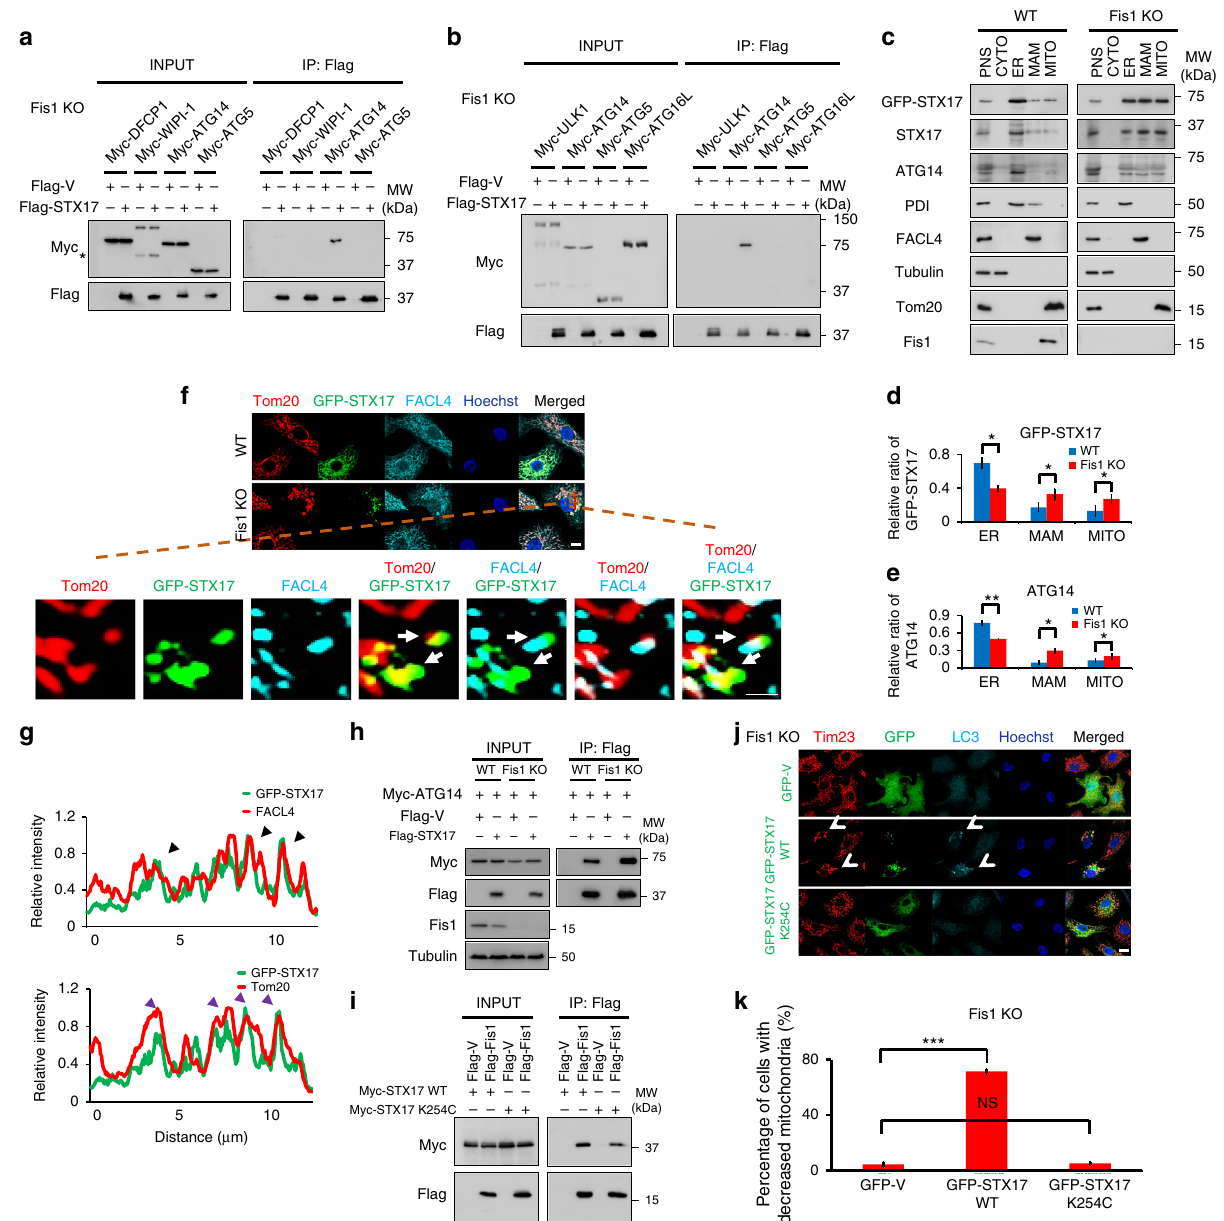
Fig. 5 Mitochondrial fi ssion 1 protein (Fis1) regulates the translocation of syntaxin 17 (STX17) onto MAM/mitochondria. a , b Fis1 knockout ( KO ) HeLa cells were transfected with the indicated plasmids. After 24 h, cells were lysed and immunoprecipitated with anti-Flag beads followed by immunoblotting. Asterisk indicates a non-speci fi c band. c Immunoblotting of subcellular fractions from wild-type ( WT ) or Fis1 KO HeLa cells expressing green fl uorescent protein (GFP)-tagged STX17 for 24 h is shown. PNS, post-nuclear supernatant; CYTO, cytosol; ER, endoplasmic reticulum; MAM, mitochondria-associated membranes; MITO, mitochondria. d , e Quanti fi cation of relative ratio of GFP-tagged STX17 ( d ) or endogenous ATG14 ( e ) in the respective subcellular fractions. * P < 0.05, ** P < 0.01 (two-tailed unpaired Student ’ s t test from three independent experiments). f WT or Fis1 KO HeLa cells were transfected with GFP-tagged STX17 (green). Cells were imaged following immunostaining for Tom20 (red) and FACL4 (fatty acid-CoA ligase 4) (cyan). Images at single focal plane were acquired. Hoechst, blue. Scale bar, 10 µ m. Cropped image was enlarged and shown as a two-dimensional deconvoluted example. White arrows indicate the colocalization of STX17 with Tom20 (mitochondria) and FACL4 (MAM). g Line scans corresponding to f . The colocalization between GFP-STX17 with FACL4 (MAM) or Tom20 (mitochondria) of Fis1 KO cells is indicated by black triangles or purple triangles, respectively. h Plasmids encoding respective proteins were transfected into WT or Fis1 KO HeLa cells for 24 h. Cells were extracted and immunoprecipitated with anti-Flag beads, followed by immunoblotting. i Plasmids as indicated were transfected into HeLa cells. After 24 h, cells were extracted and co-immunoprecipitated with anti-Flag beads, followed by immunoblotting with anti-Myc and anti-Flag antibodies, respectively. j Fis1 KO HeLa cells were transfected with GFP-tagged plasmids (green) as indicated. Cells were fi xed and stained with Tim23 (red) and LC3 (cyan) antibodies. Representative confocal microscopy images are shown. Hoechst, blue. Scale bar, 10 µ m. Arrowheads indicate mitophagic cells. k Mitophagic cells as shown in j of Fis1 KO cells were quanti fi ed. *** P < 0.001, NS, not signi fi cant (two-tailed unpaired Student ’ s t test, n = 150 cells from three independent replicates). Error bars indicate SD ( d , e , k